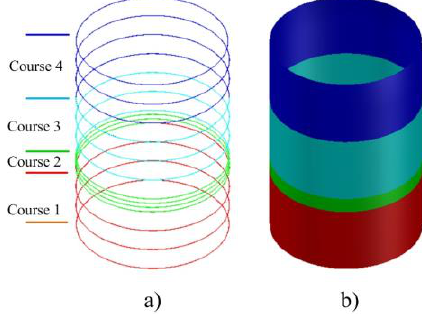
Figure 3 . Illustration of creating a solid model of a shell wall